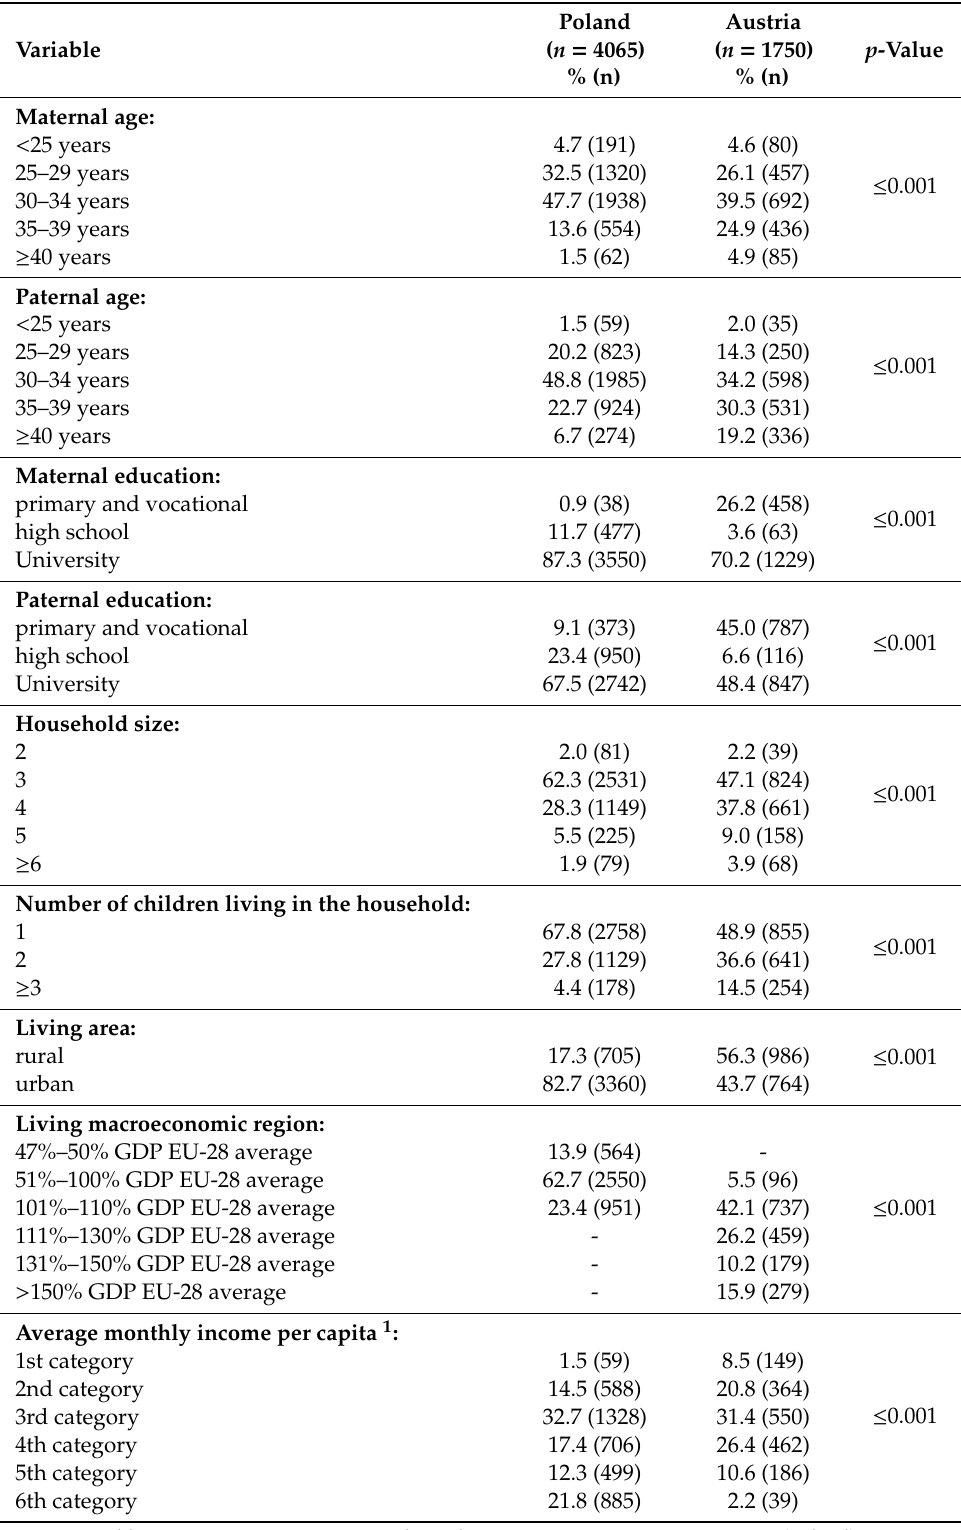
Table 1. Study group sociodemographic